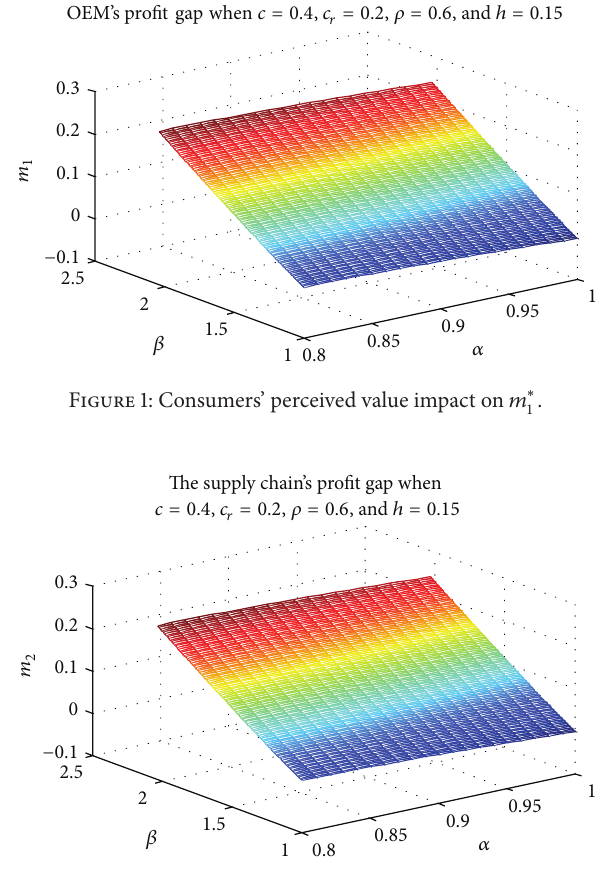
Figure 2: Consumers’ perceived value impact on 𝑚 ∗ 2 .